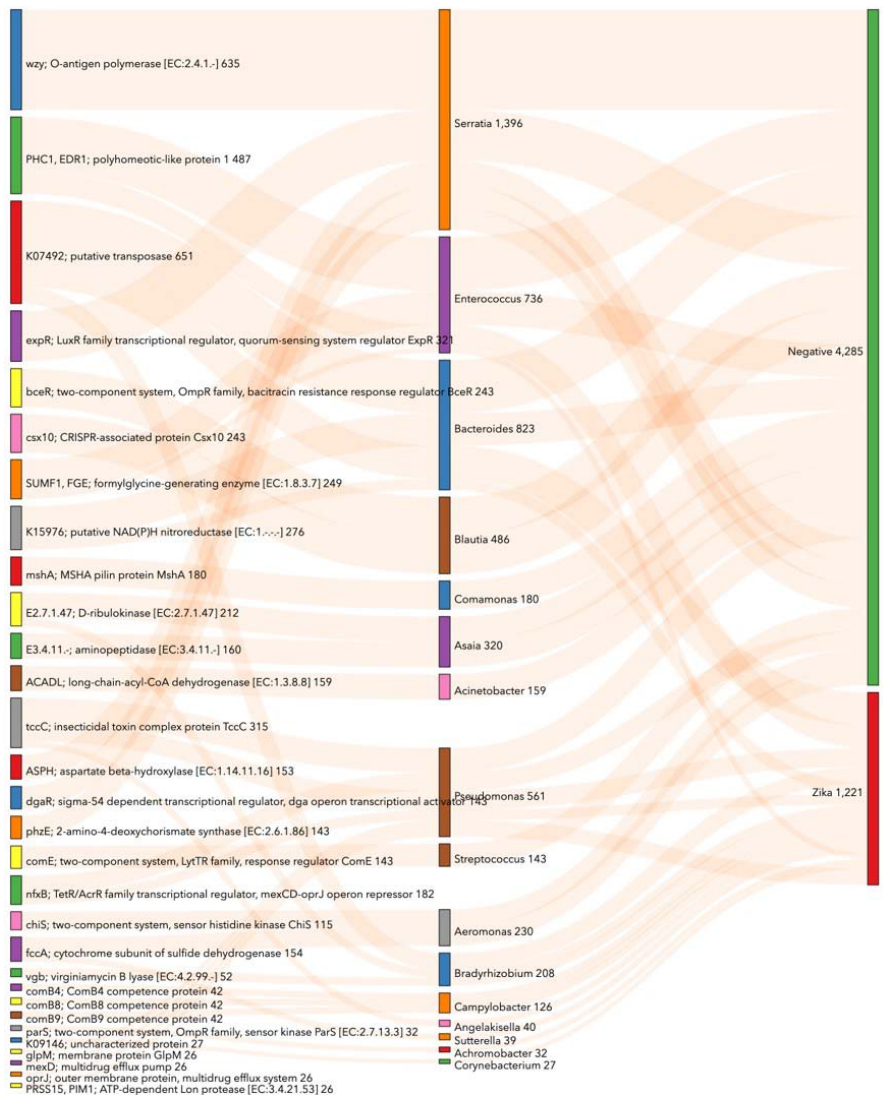
Figure 7. Enriched KEGG genes according to bacteria associated with midgut naturally infected with ZIKV in Colombian Ae. aegypti . This Sankey visualizes KEGG pathway groups’ significance ( p < 0.05) with ANCOM ‐ BC analysis. The numerical value shows PICRUSt2 gene counts correspond ‐ ing with taxonomy at the genus level. This chart shows the top 20 KEGGs per category by count. For an interactive view, visit https://observablehq.com/d/cd9c60c5c86289ce (accessed on 20 August 2022).